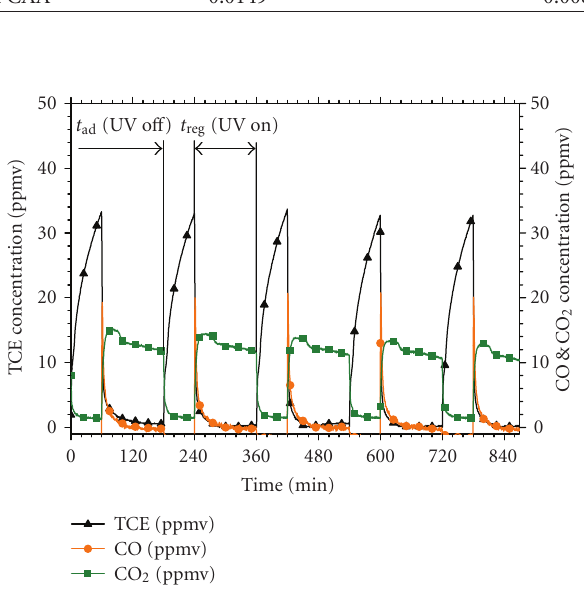
Figure 6: Transient TCE, CO, and CO 2 concentration at reactor outlet for the discontinuous oxidation of TCE on PCAA (50ppm TCE inlet concentration, mode B: t reg = 2 · t ad = 120